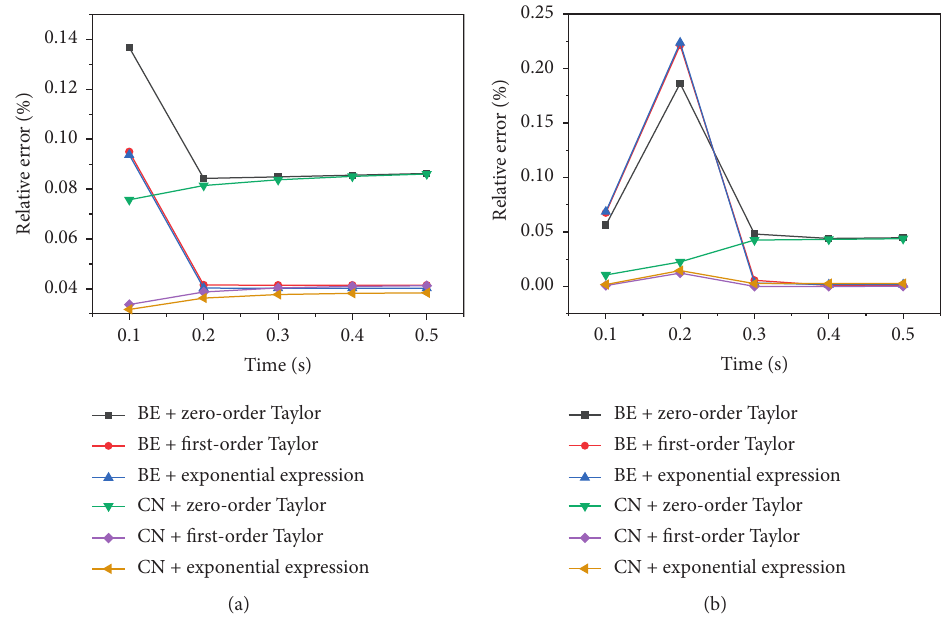
Figure 2: Relative power error of TWIGL reactivity insertion problem in Δ t � 10 ms.